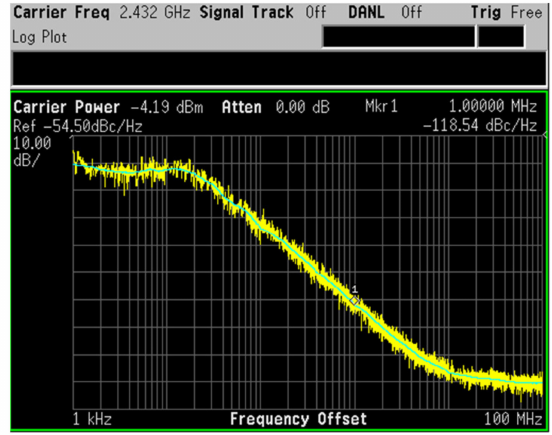
Figure 11. Measured phase noise at 2.5-GHz carrier